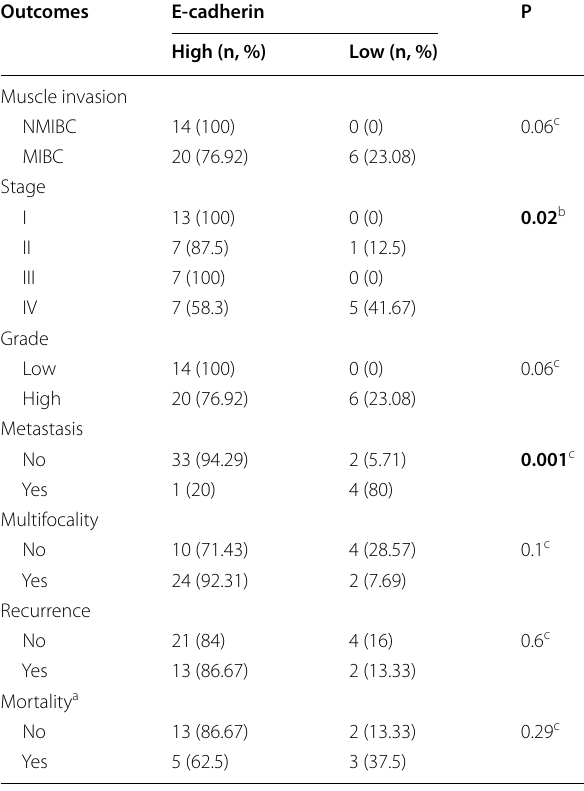
Table 1 Association of E-cadherin expression and outcomes (muscle invasion, stage, grade, metastasis, multifocality, recurrence, and mortality)